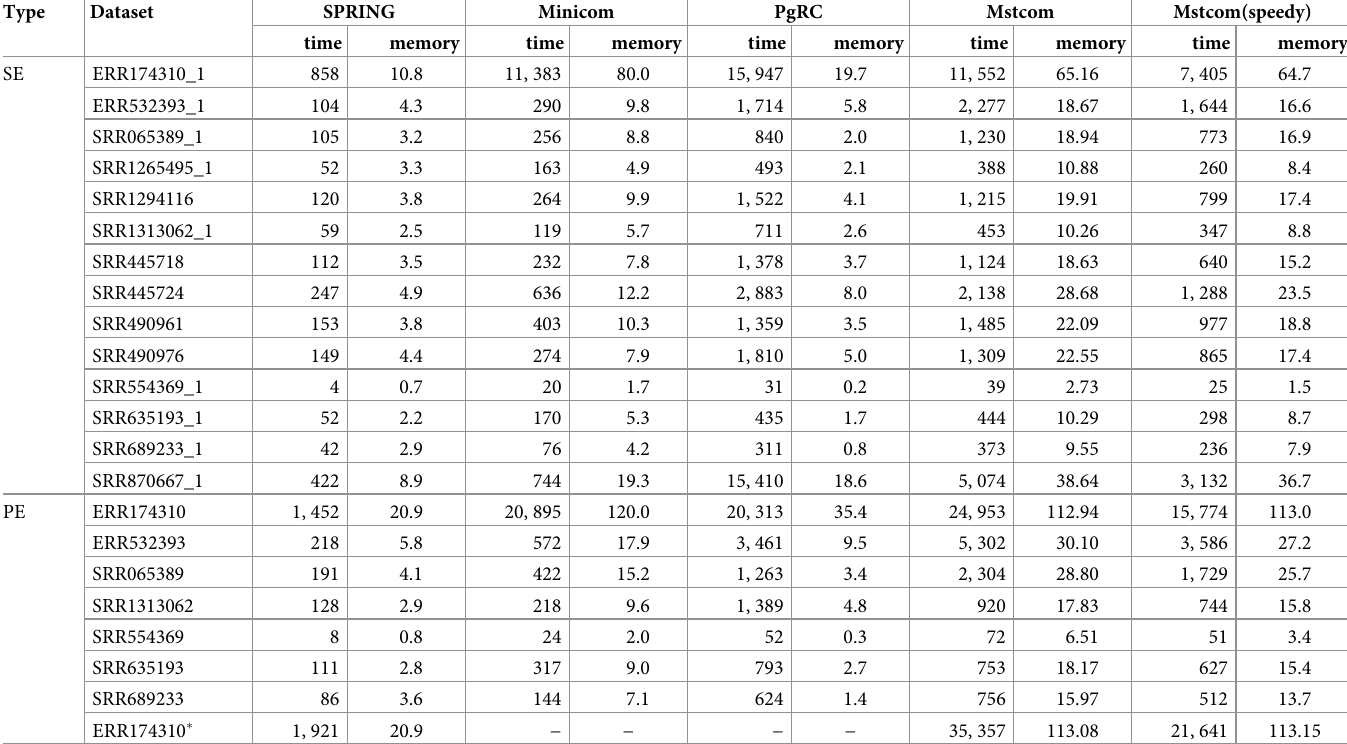
Table 2. Compression time (seconds) and memory usage (GB) of different methods under the order-free mode. Type Dataset